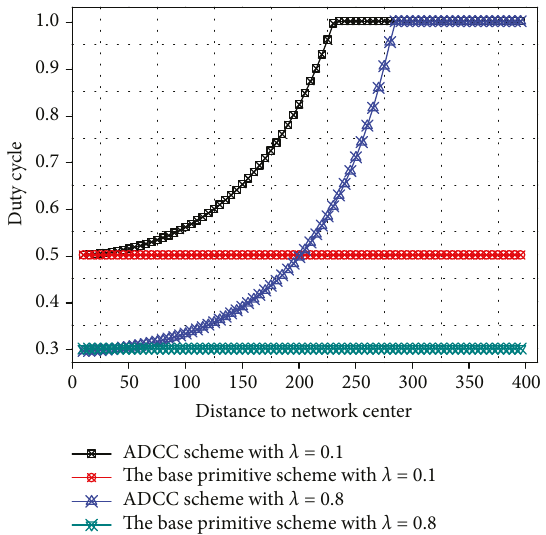
Figure 9: The duty cycle of di ff erent nodes with di ff erent initial duty cycle.